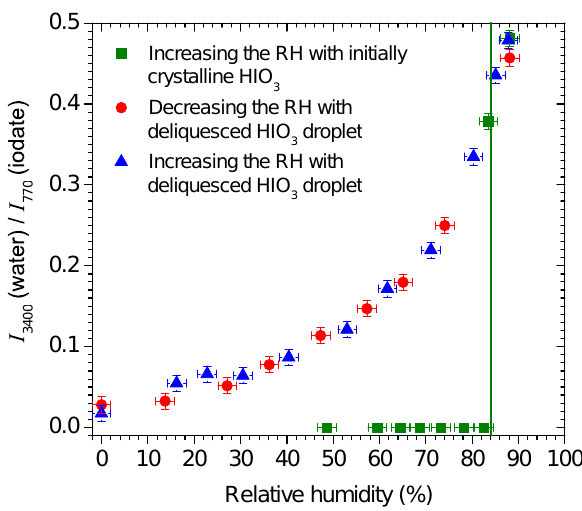
Fig. 4. Intensity ratio of peaks roughly centred at 3400cm − 1 ( I 3400 , OH stretch, i.e. water), and 770cm − 1 ( I 770 , iodate) as a function of RH determined from spectra such as those shown in Fig. 2 and Fig. 3. The vertical green line indicates the expected deliquescence point (Kumar et al., 2010) and is in good agreement with the RH at which HIO 3 clearly takes up water to become an aqueous liquid droplet. The estimated uncertainty on our RH measurement is 2%. The intensities I 3400 and I 770 were determined by integrating the background subtracted signal between 2900–3800cm − 1 and 500– 1000cm − 1 , respectively, for the liquid droplets. A value of zero was taken when the spectra were dominated by crystalline peaks (up to 82.5% RH). All these measurements were done with a single particle/droplet as the RH was initially increased around a dry crys- talline particle until it had fully deliquesced (green), and then as the RH was reduced to 0% RH (red), and then on the following day as it was increased again (blue).